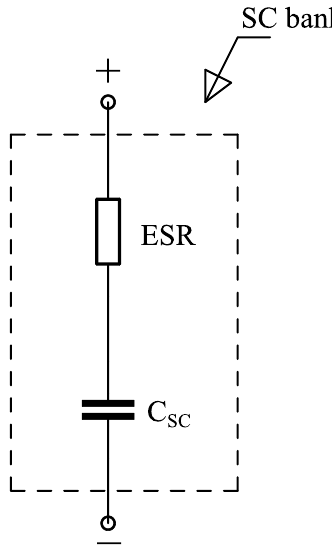
Figure 8. All the supercapacitor bank parameters used for modeling are given in Table 2.